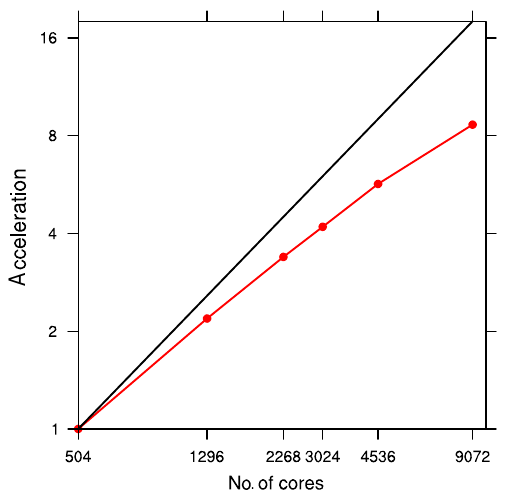
Figure 1. Parallel acceleration of the SL-AV20 experimental con- figuration on the grid of 3024 by 1513 points with respect to 504 cores (red line); linear acceleration – black line.